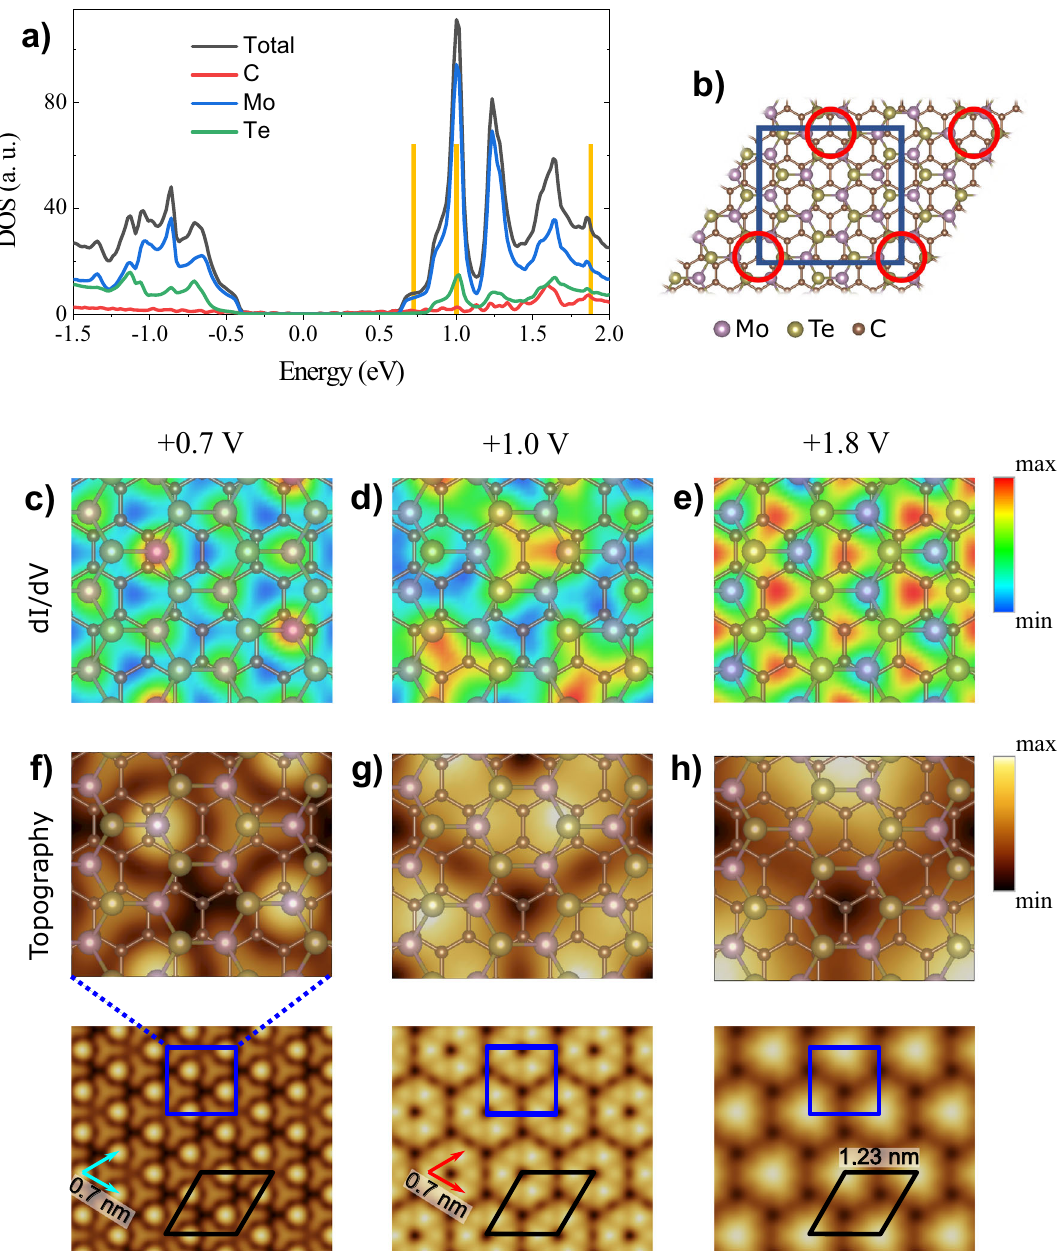
ffiffiffi p Fig. 7 DFT electronic structure calculation and STM simulations for the 2 3 R30 ∘ MoTe 2 /graphene superstructure. a Total density of states (DOS) and the sum of the partial DOS of the different atoms, Mo (blue), Te (green), C (red) in the supercell. Yellow lines mark the energy values of the maps shown in ( c – e ). b Relaxed geometry, where the red circles show the corner of the commensurate supercell and the blue square highlights the spatial area shown in ( c – e ) and in ( f – h ) upper panels. c – e Simulated dI/dV maps at z = 5 Å for + 0.7, + 1.0, + 1.8 V, respectively. Each map is renormalized individually to its maximum. Maximum (minimum) values are 1.22 × 10 − 5 (9.26 × 10 − 6 ), 2.32 × 10 − 4 (2.26 × 10 − 4 ), and 1.27 × 10 − 3 (1.06 × 10 − 3 ) in 1/( Å 3 V) units. f – h Simulated STM topography images calculated for V = + 0.7, + 1.0, and + 1.8 V tip-bias voltages. Each map is renormalized individually to its maximum apparent height. Maximum (minimum) values are 6.23 (6.05), 6.14 (6.12), and 6.24 (6.22) in Å . Upper panels show the STM topography images in the spatial area used in ( c – e ), while lower panels are the same topography images in larger spatial dimensions. The distinct higher-indexed Moiré-patterns, such as the λ 1110 (black rhombus in g , h ) and the λ 0211 (red and light-blue arrows in f , g ) are explicitly apparent on the simulated STM images. A transition from λ 1110 (1.23 nm) to λ 0211 (0.7 nm) can be seen as the bias changes from + 1.8 to + 0.7 V, displaying a similar variable feature of the simulated patterns with the bias as detected in the measured STM image at the corresponding voltage in Fig. 2c. As lower voltage ( + 1 V) in the simulation (Fig. 7g), second neighbor the higher-indexed λ 0211 tends to have a weaker potential Te atoms appear as protrusions and their center as depression resulting in an additional 0.7 nm periodicity in the simulated STM modulation, it is more prone to be perturbed by weak substrate image besides the supercell periodicity. This 0.7 nm periodicity is effects such as the presence of the SiC, which is neglected in our ffiffiffi p equal to the 3 overtone ( λ 0211 ), which is also detected in the simulations. This may contribute to the small differences found